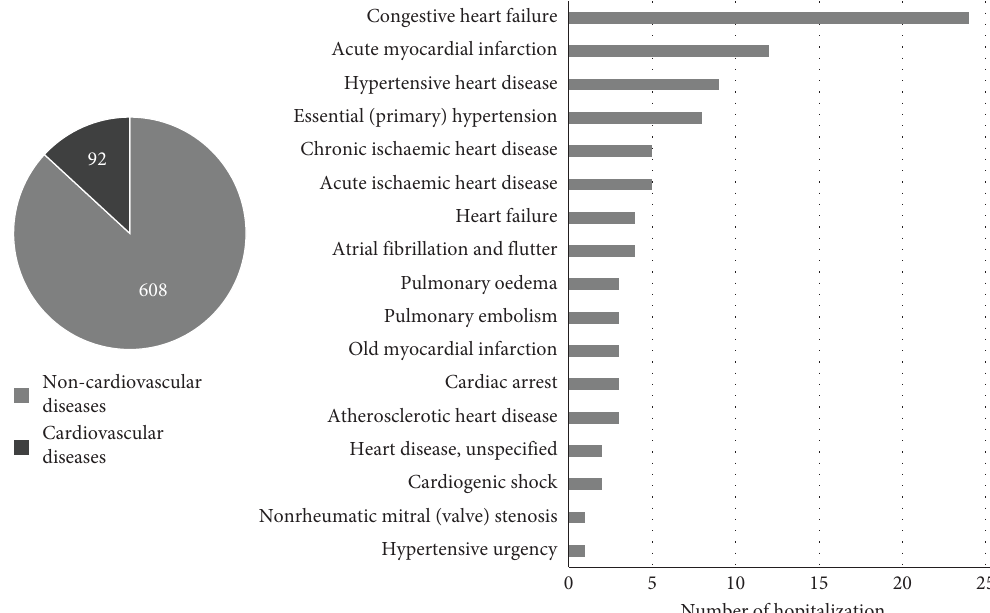
Figure 4: Early diagnosis during hospitalization among Hajj